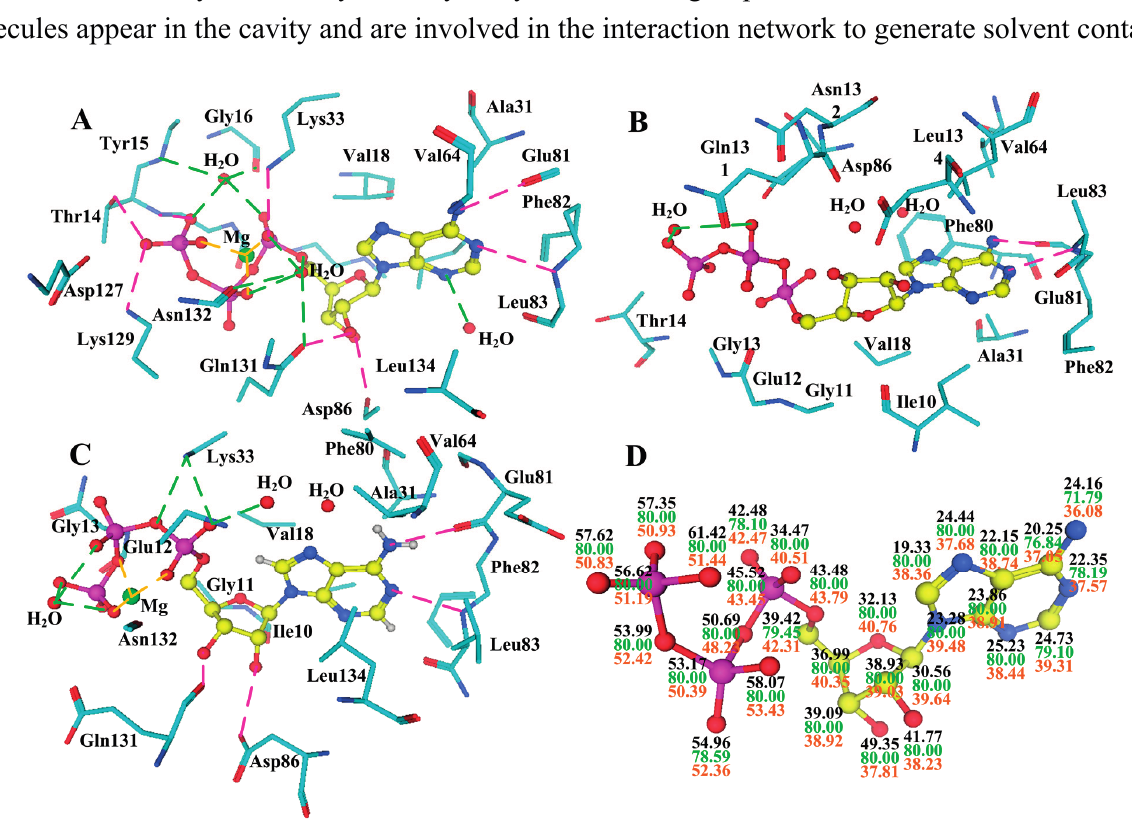
Figure 11. Variations of the ATP binding site through conformational fluctuations. ( A ) is the interaction network of ATP in monomeric CDK2 (coordinates 1HCK, resolution 1.9 Å); ( B ) is in CDK2/cyclin A dimer (1FIN, 2.3 Å); ( C ) is in the phosphorylated dimer (4EOM, 2.3 Å), respectively; ( D ) The B-factor (Å 2 ) distribution for the ATP atoms across the monomeric CDK2 (in black font) CDK2/cyclin A complex (in green) and phosphorylated dimer (in